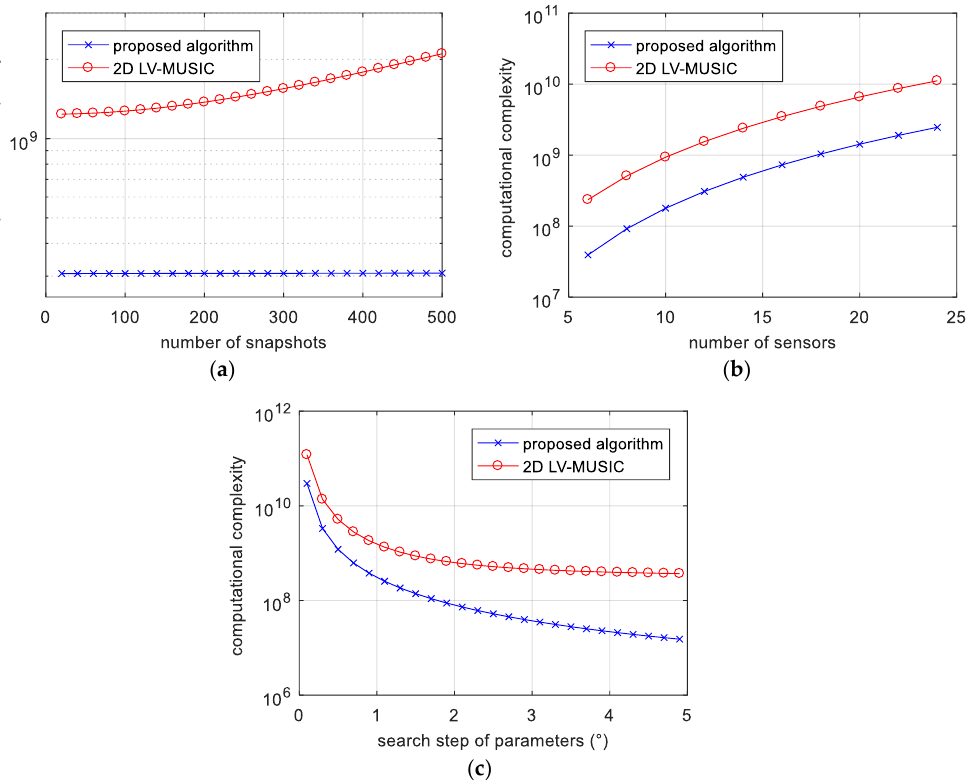
Figure 3. Computational complexity versus ( a ) the number of snapshots (for 12 sensors and 1° search step); ( b ) the number of sensors (for 300 snapshots and 1° search step), and ( c ) the search step of parameters (for 12 sensors and 300 snapshots).